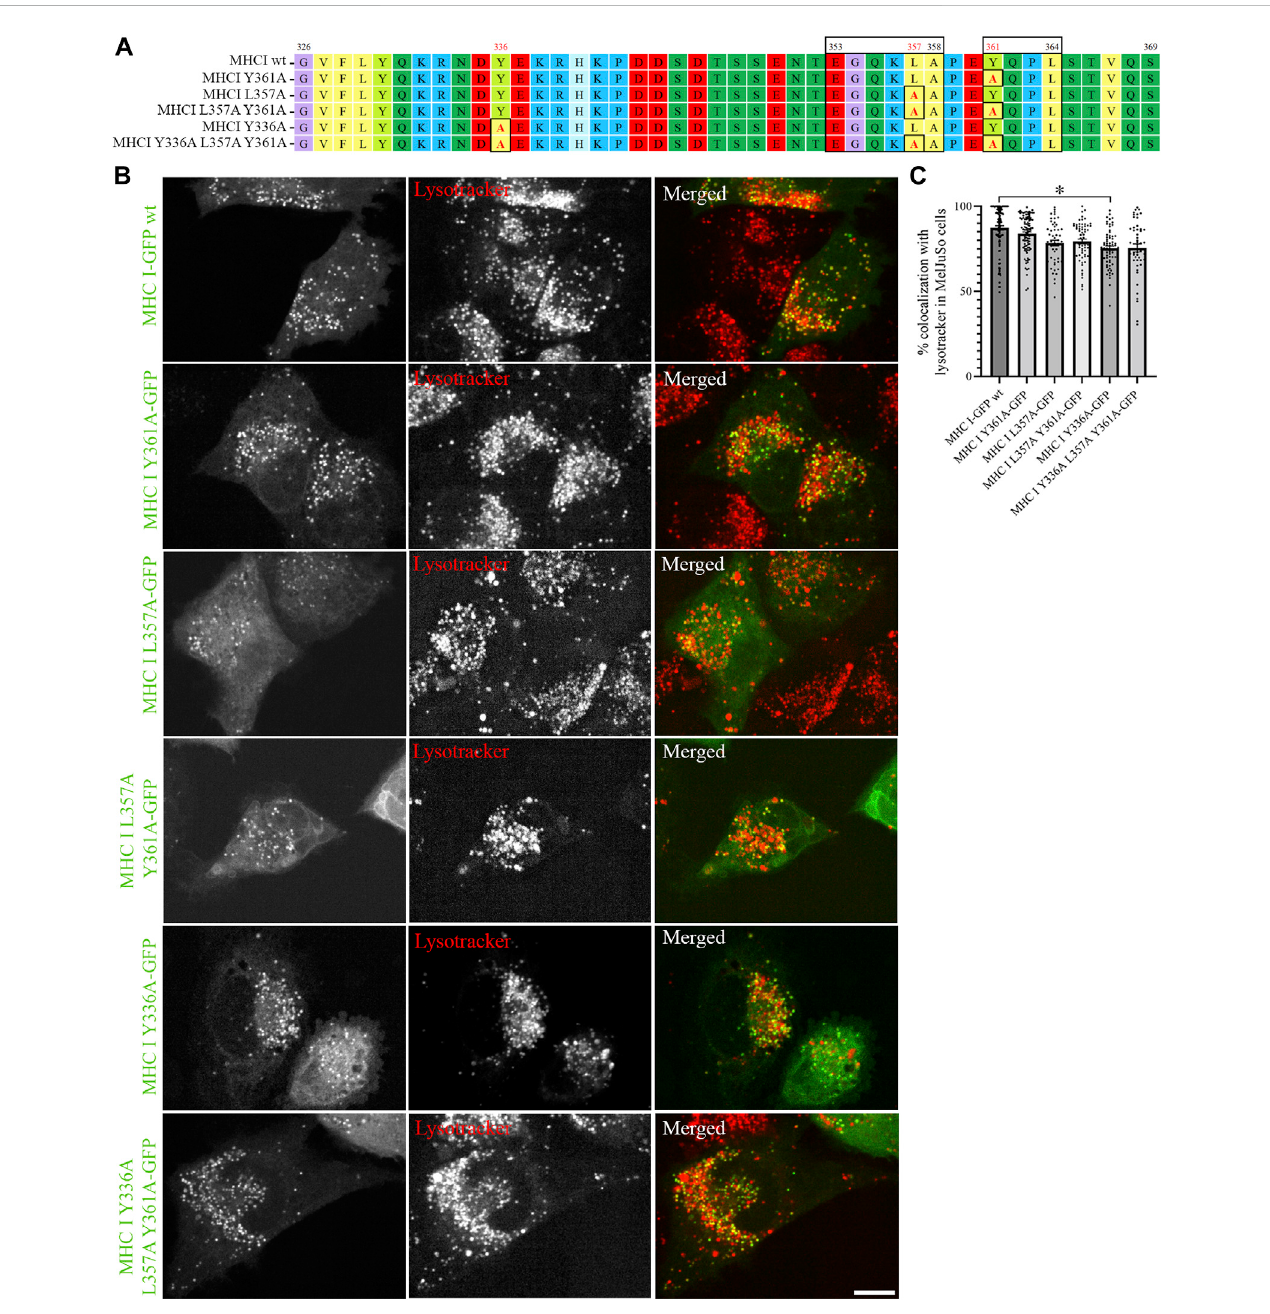
FIGURE 2 PointmutationsinputativesortingmotifsofAtlanticcodMHCIvariant1cytosolictaildonotaffectitsintracellularlocalizationinMelJuSOcells. (A) Amino acid sequences of Atlantic cod MHC I variant 1 wild type (wt) and its substitution mutants generated by introducing point mutations in hypothetical sorting motifs. All substitutions are marked with black box and red letters. Numbers above the sequences mark amino acid positions. (B) Representative images of MelJuSo cells transiently transfected with Atlantic cod MHC I-GFP variant 1 or the fi ve substitution mutants (green). The cells were stained with lysotracker red and imaged using an Andor Dragon fl y spinning-disk confocal microscope. Colocalization between green and red channels results in yellow signal in the merged panels. Scale bar: 10 μ m. (C) The graph represents the percentage of colocalization between Atlantic cod MHC I variant 1 wt or the fi ve substitution mutants and lysotracker red. Colocalization was done by object-based analysis using ImageJ software. Values represent the mean ± s.e.m. from at least three independent experiments. n ≥ 48 cells. * p < 0.05 (Two-tailed paired Student t